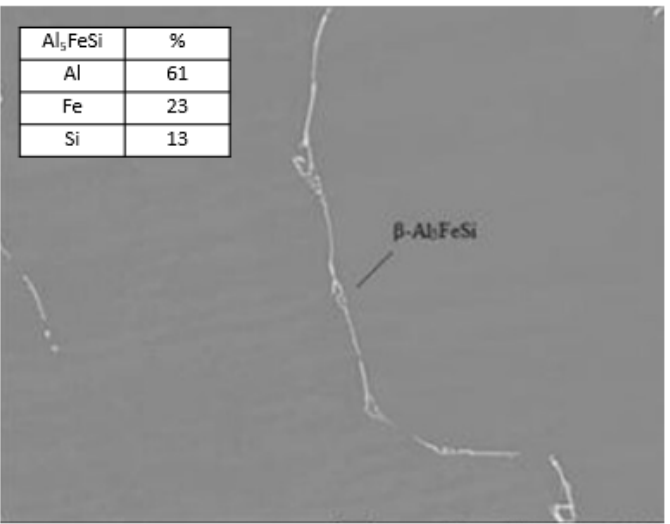
Figure 2. SEM micrograph of a sample of the alloy A6063 in the as-cast condition with semi-quantitative analysis by EDS.